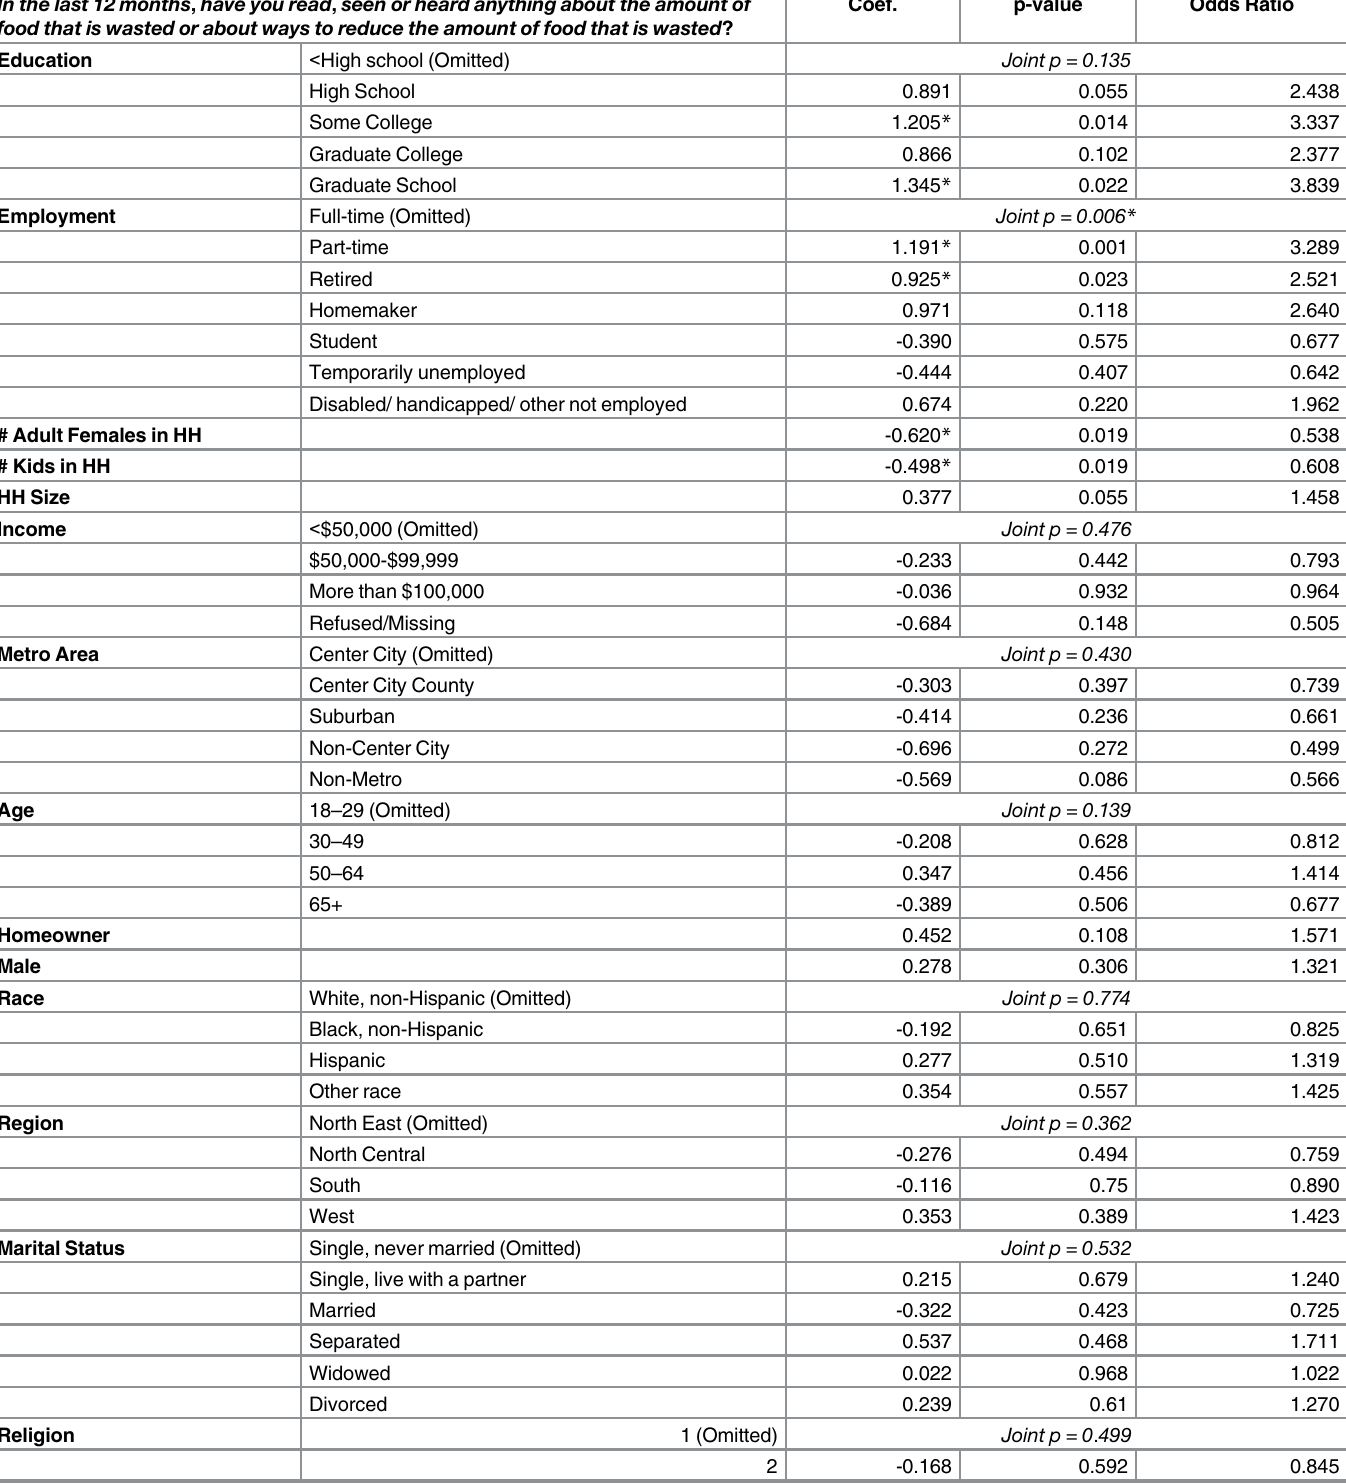
Table 2. Food waste awareness regression model. In the last 12 months , have you read , seen or heard anything about the amount of food that is wasted or about ways to reduce the amount of food that is wasted